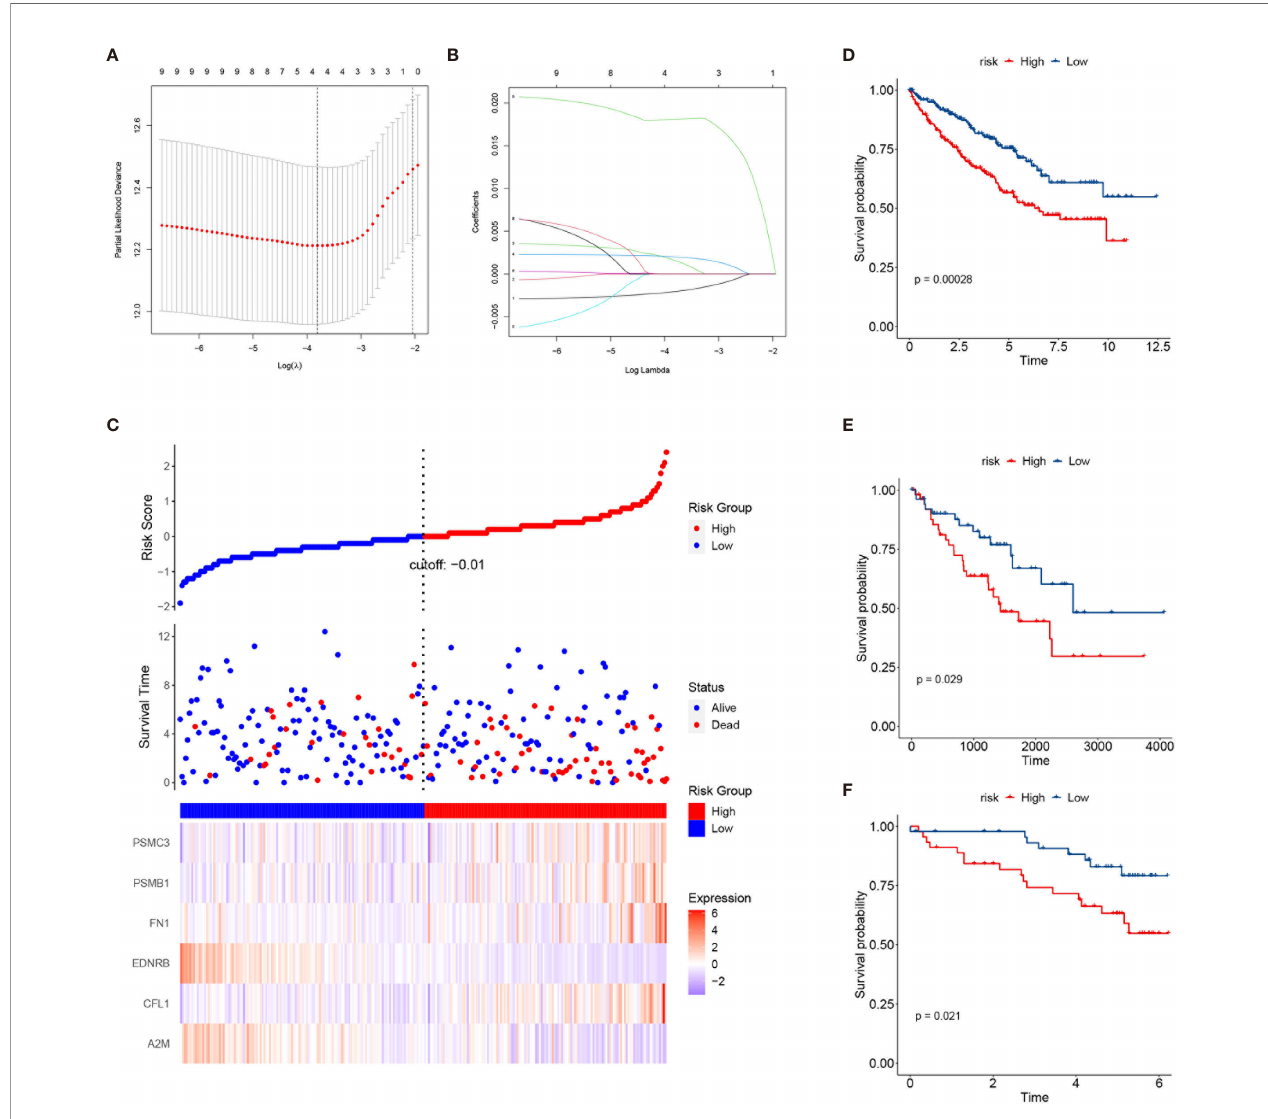
FIGURE 9 | Construction of a risk prediction model based on the key genes in the three subclasses. (A) Tuning parameter ( l ) screening in the least absolute shrinkage and selection operator (LASSO) regression model. (B) LASSO coef fi cient pro fi les of the common genes. (C) From top to bottom are the risk score distribution, survival overview, and heatmap analysis of six genes. (D – F) Kaplan – Meier plots of overall survival (OS) according to the risk scores in The Cancer Genome Atlas (TCGA) training set (D) , TCGA testing set (E) , and the International Cancer Genome Consortium (ICGC) cohort (F)